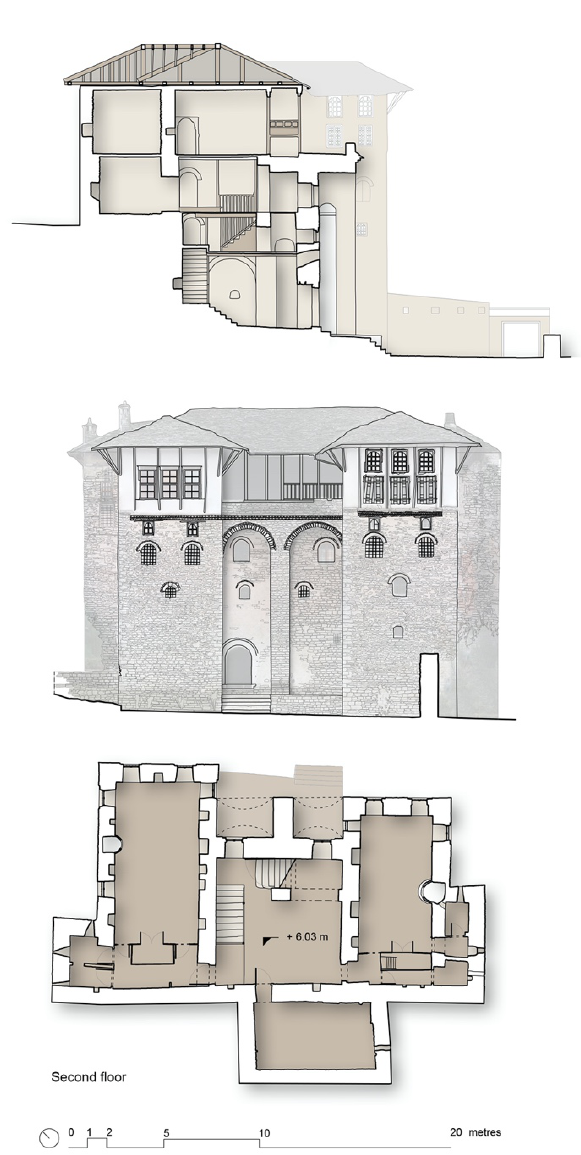
Figure 3. Plan, main façade and cross section of Zekate house (Survey: G. Cara, K. Kumi, M. Gega, F. SHillaku, J. Tuci. Graphic editing: E.